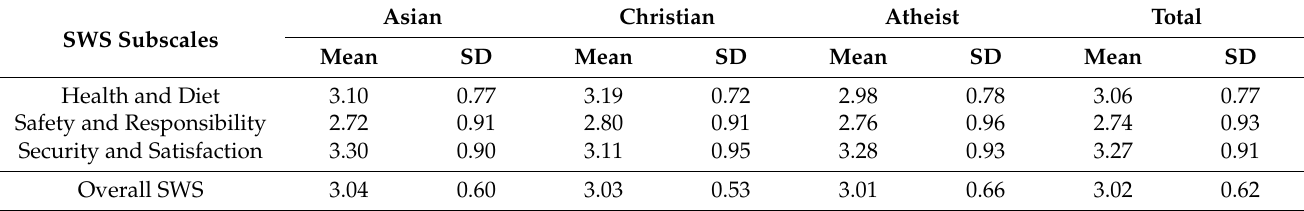
Table 10. Cross-tabulation between SWS subscales and religious affiliation.